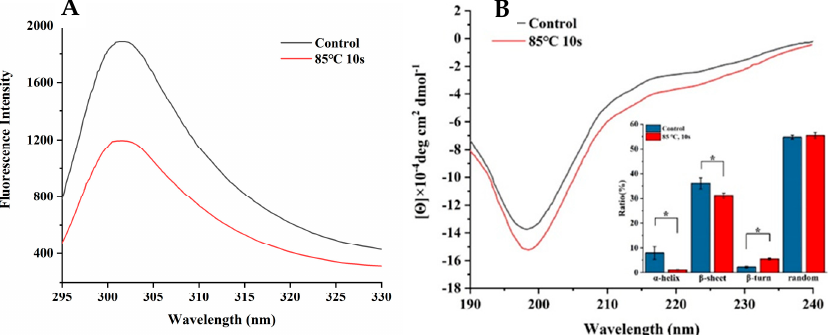
Figure 6 . Fluorescence spectra ( A ) and circular dichroism spectra ( B ) of EWP-Ca and sterilization treatment EWP-Ca. * indicates significant differences ( p < 0.05).